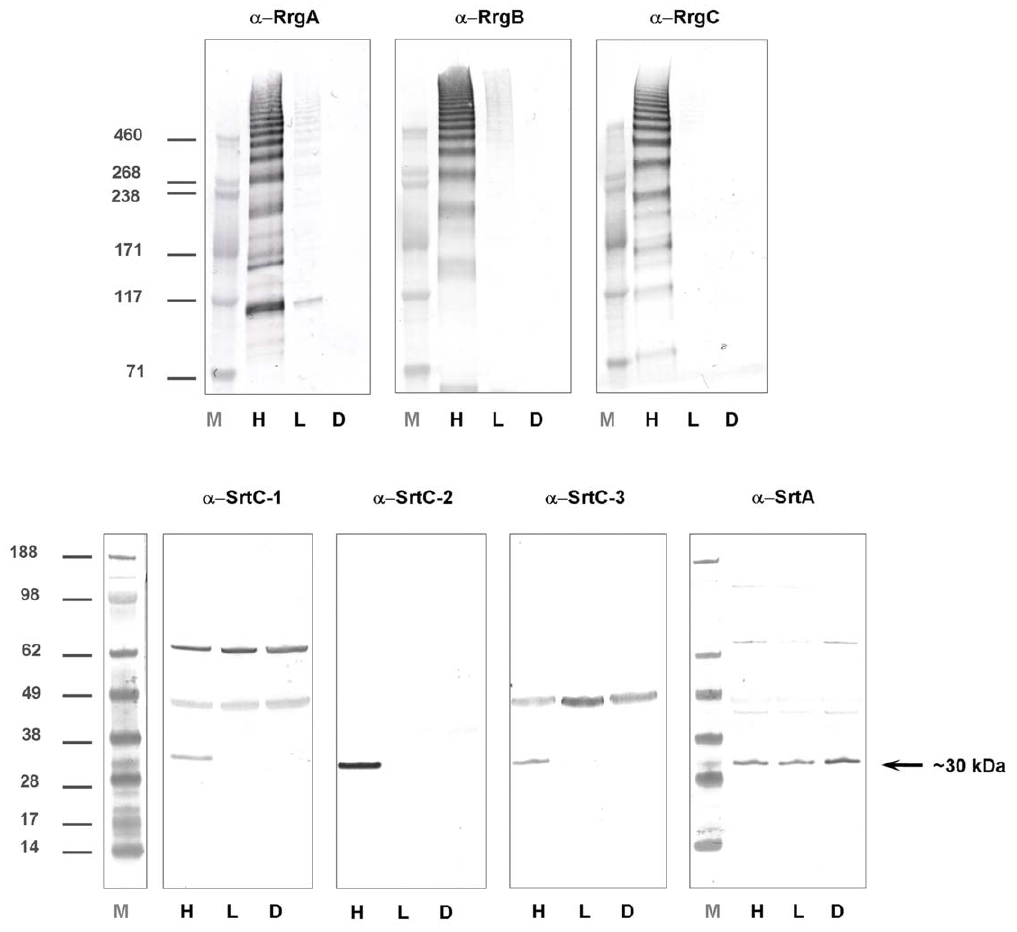
Figure 4. PI-1 encoded proteins are not expressed in RrgB negative bacteria. WB analysis performed on whole bacterial lysates of TIGR4 H (H), L (L) or TIGR4 L depleted of RrgB positive bacteria (D), using polyclonal mouse antisera against RrgA, RrgB, RrgC (see High molecular weight ladders), SrtC-1, SrtC-2 ,SrtC-3 (see bands indicated by arrows) and SrtA (used as loading control).